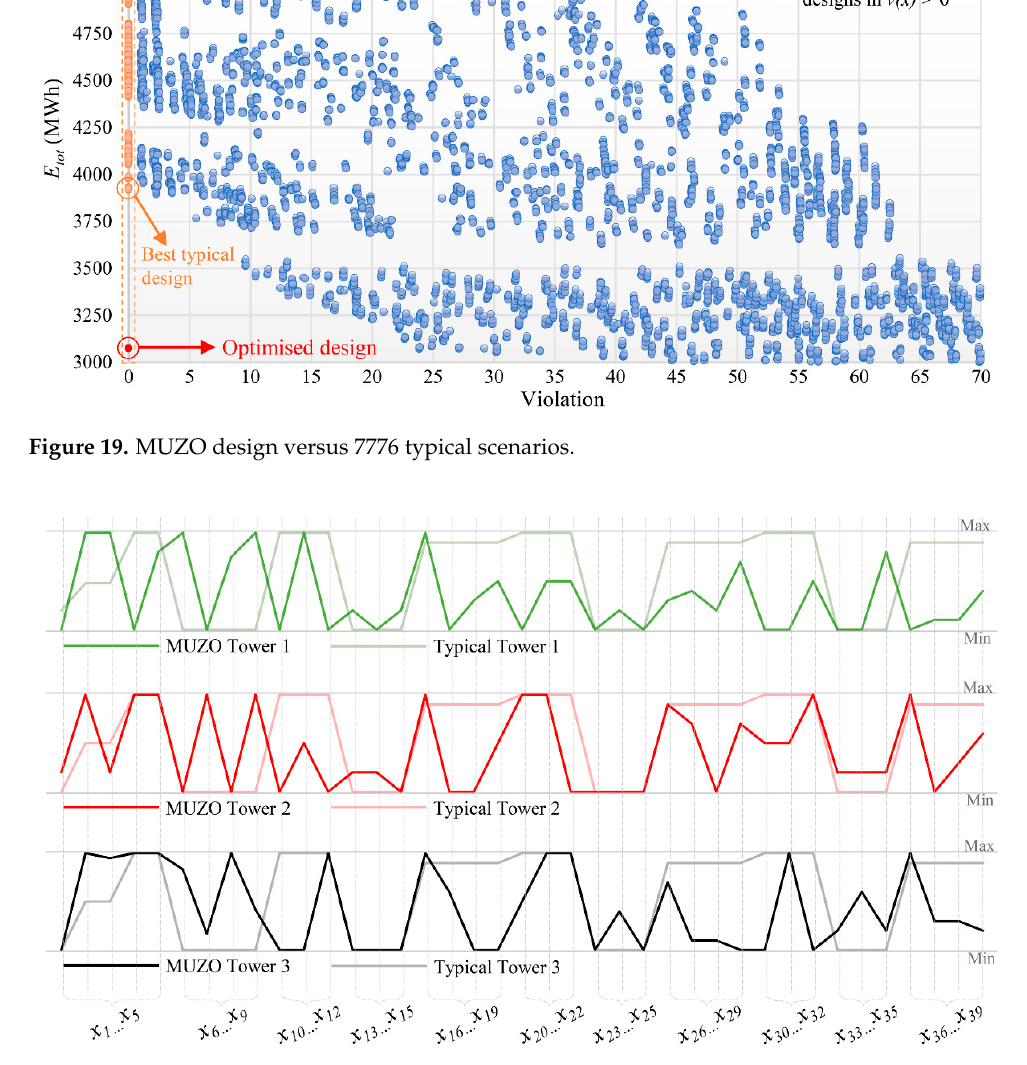
Figure 20. Parameters of MUZO design and the best typical scenario.